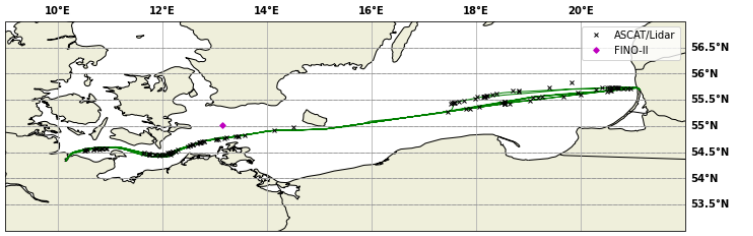
Figure 2. Collocation of ASCAT grid cells with Kiel ferry lidar path with Kiel on the west and Klaipeda on the east side of the route. The x ’s correspond to the central lidar position in the hourly average. The same process of co-location was carried out for the FINO2 data when SST infor- mation was recorded (2013–2017), where only one ASCAT grid cell enveloping the FINO2 position was used. This accounts for 2688 1 h complete